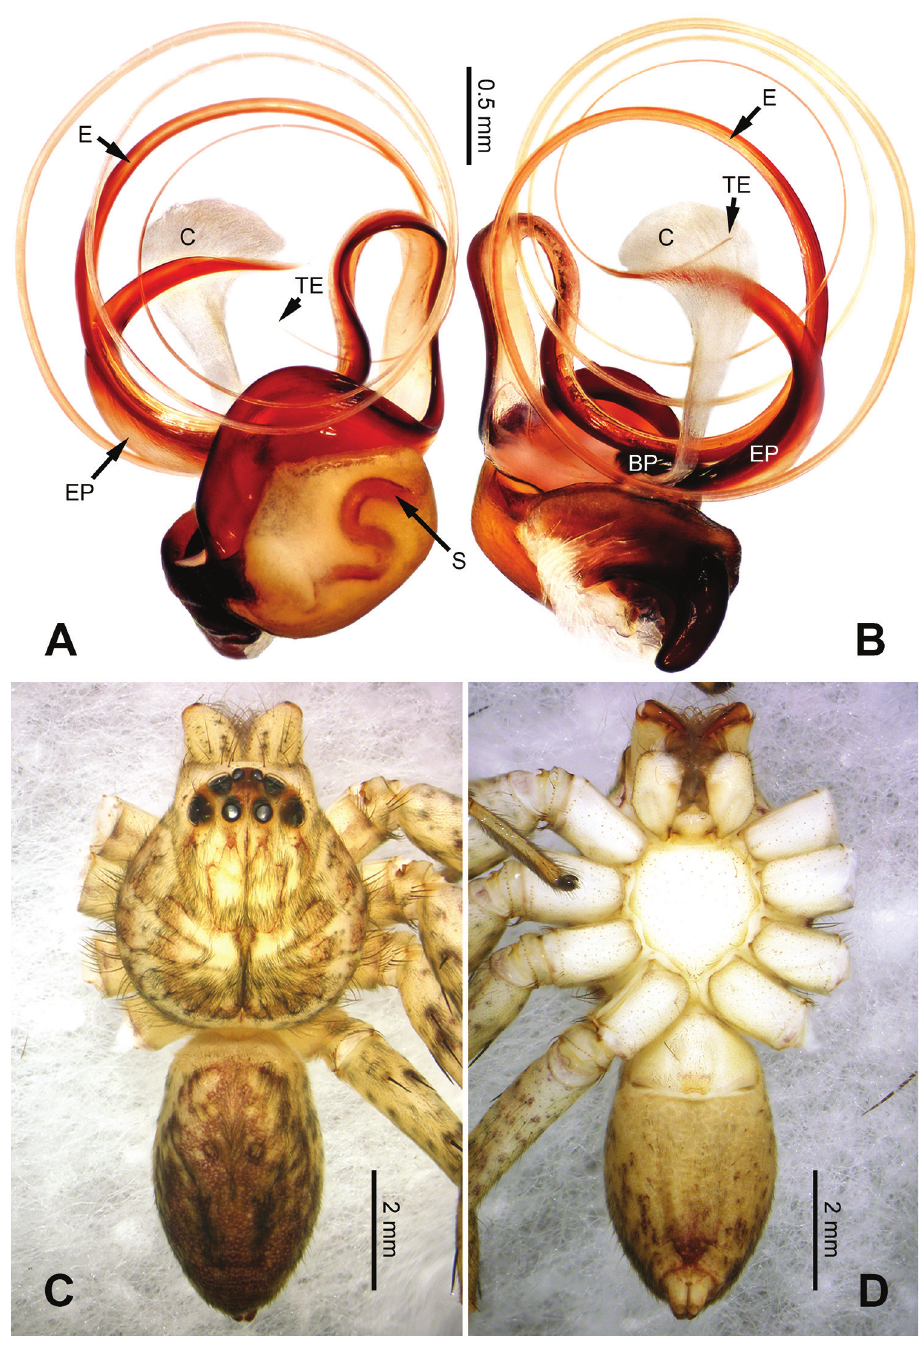
Figure 13. Pseudopoda maeklongensis Zhao & Li, sp. n., male holotype. Right bulb horizontally flipped for the sake of comparison. A Bulb, ventral view B Bulb, dorsal view C Habitus, dorsal view D Habitus, ventral view. Scale bar equal for A, B